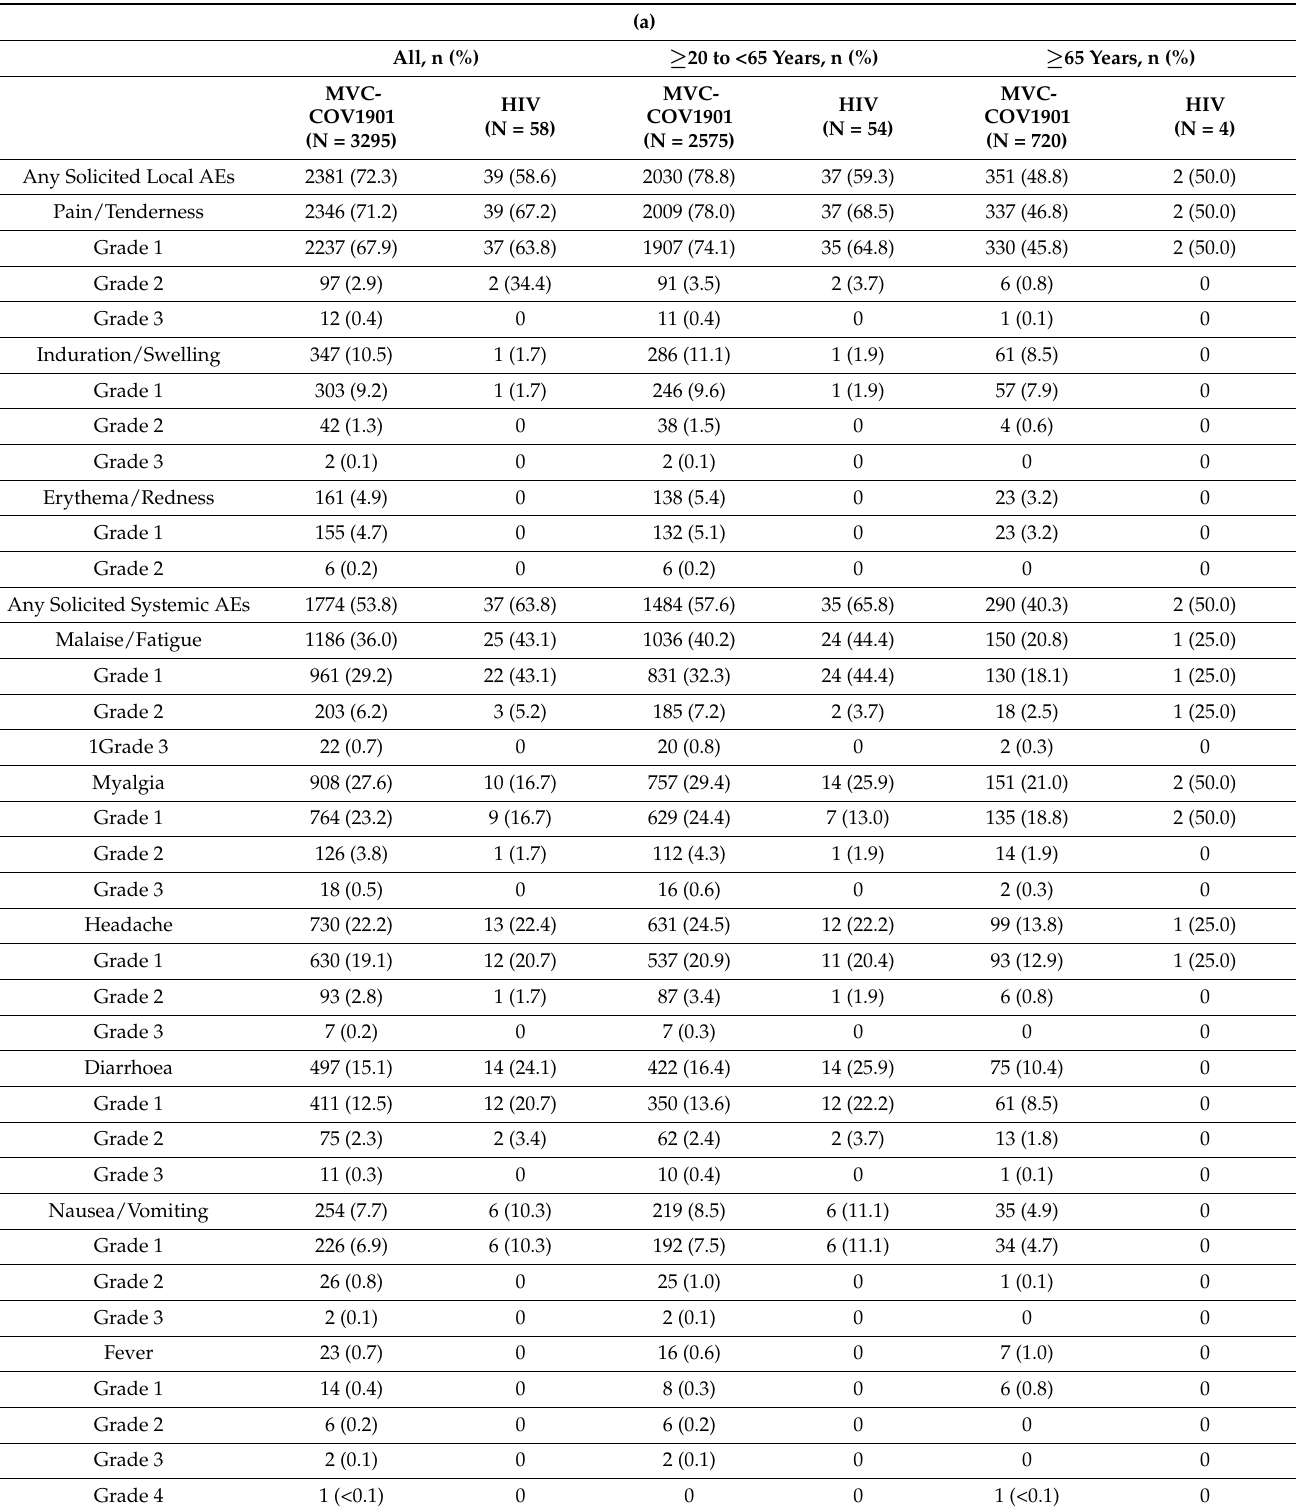
Table 2. ( a ) Solicited adverse events after any dosing. ( b ) Summary of unsolicited adverse events and other adverse